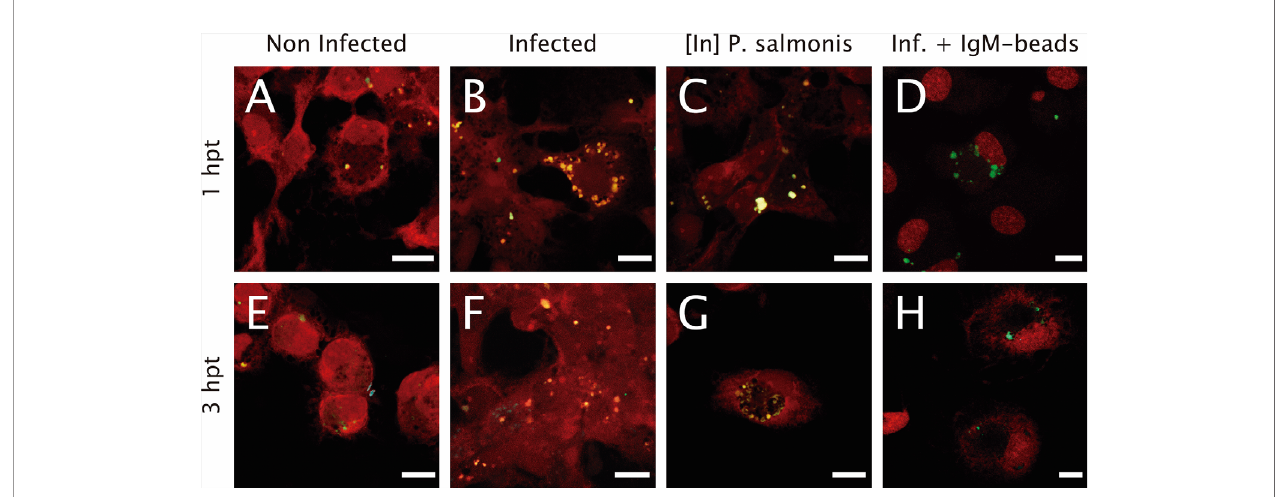
FIGURE 1 | Lysosomal acidi fi cation in infected macrophage-enriched cell cultures treated with IgM-beads. Macrophage-enriched cell cultures obtained from Atlantic salmon head kidneys were incubated with P. salmonis at a MOI of 10 bacteria/cell. The infected cells were treated with IgM-beads and analyzed at 1 and 3 hpt. The macrophage-enriched cell cultures were treated with the LSYB probe (green and blue) to stain lysosomes and analyze their pH. (A, E) Non-infected macrophages analyzed at 1 and 3 hpt. Macrophages-enriched cell cultures infected with P. salmonis for 1 hpt (B) , and 3 hpt (F) . Macrophage-enriched cell cultures incubated with inactivated (In) P. salmonis for 1 hpt (C) and 3 hpt (G) . Macrophage-enriched cultures infected with P. salmonis and treated with IgM-beads for 1 hpt (D) and 3 hpt (H) . Scale bar: 10 m m.